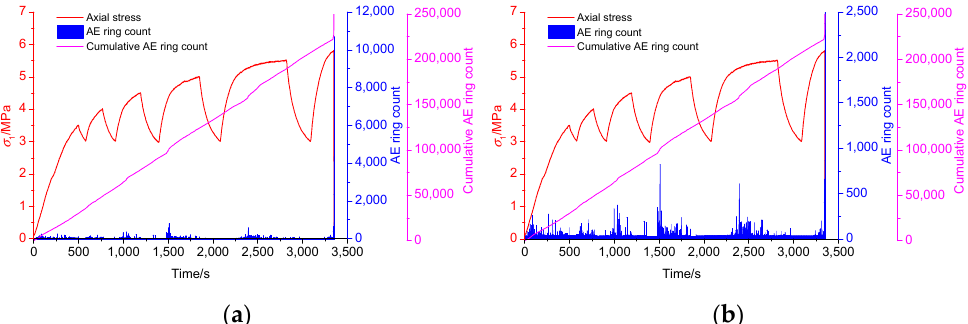
Figure 5. AE ring count and axial stress versus time curves for coal specimen subjected to cyclic loading and unloading. ( a ) AE ring count scale not magnified; ( b ) AE ring count scale magnified ~5X.